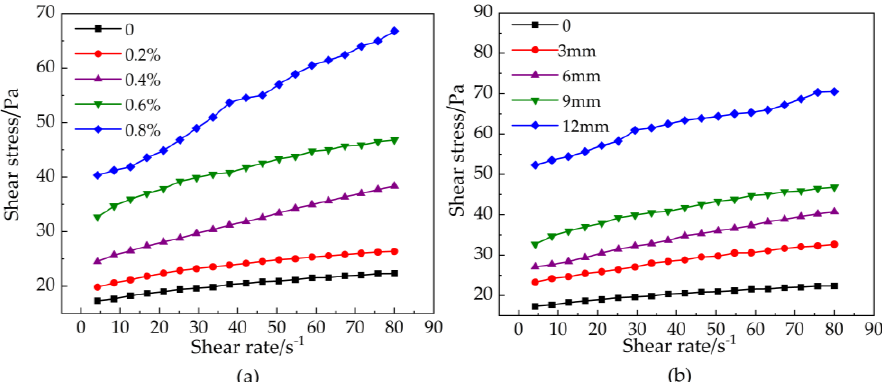
Figure 5. The relationship between shear rate and shear stress: ( a ) fiber content ; ( b ) fiber length. Table 4. Fitting analysis of the modified Bingham rheological model.